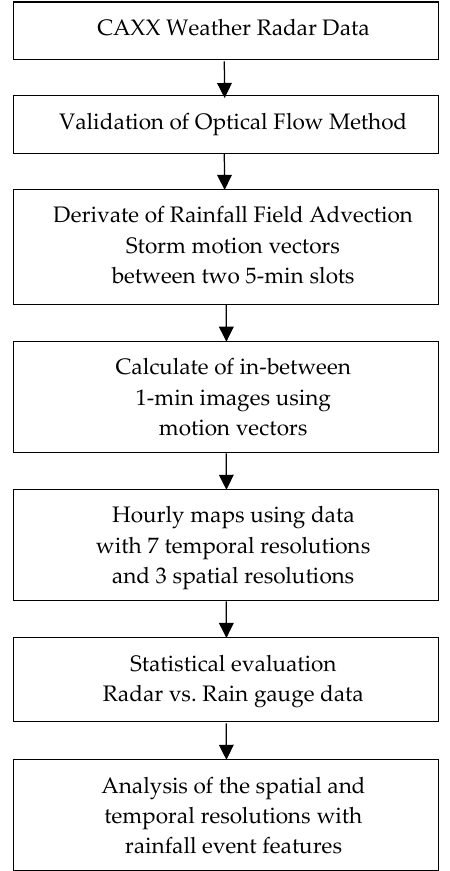
Figure 5. Workflow of data processing.